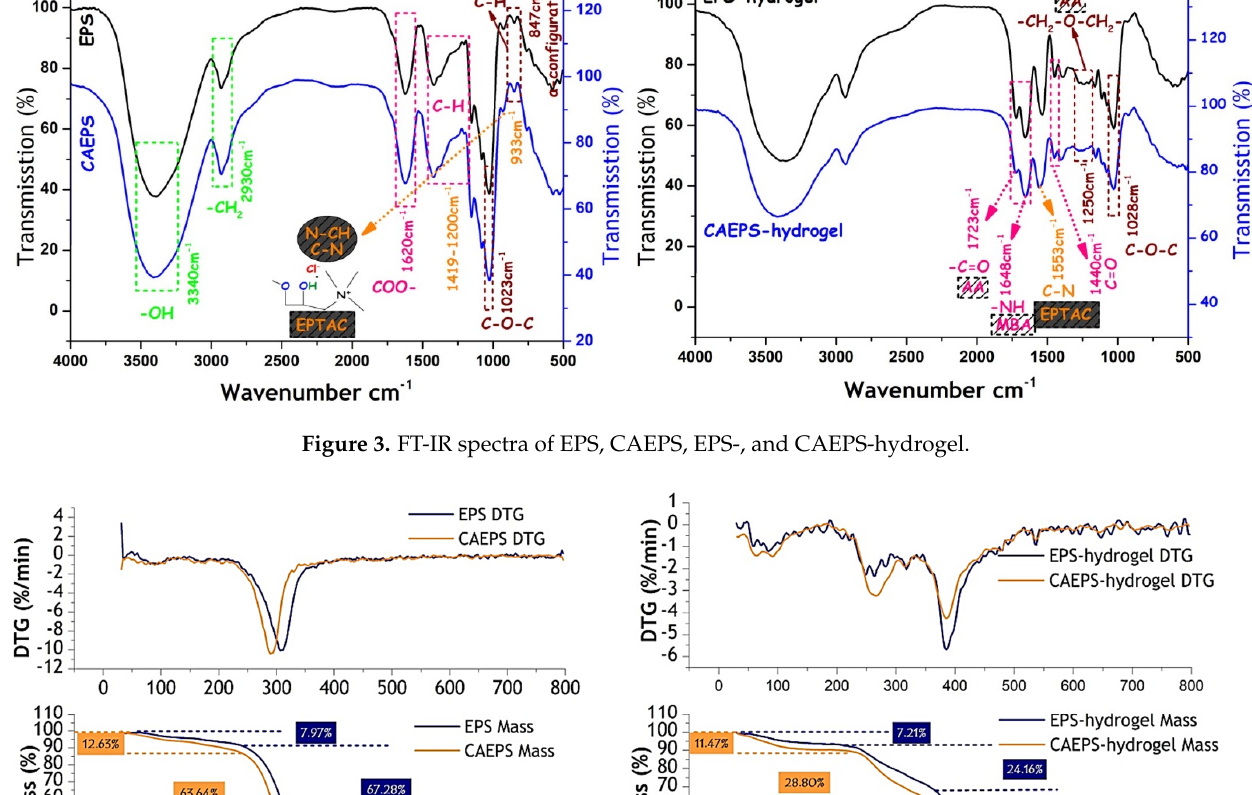
Figure 3. FT-IR spectra of EPS, CAEPS, EPS-, and CAEPS-hydrogel. 2.1.4. TG